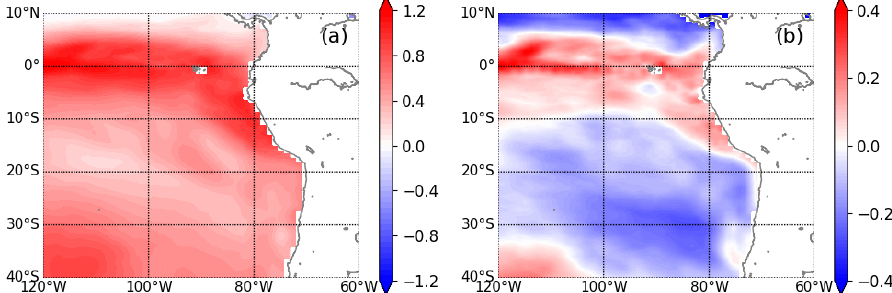
Figure 12. SST composite mean over all days with MCB cluster 4 and 6 minus the (a) 50th percentile of winter SST and (b) 70th percentile of winter SST in the mid-Pliocene experiment of